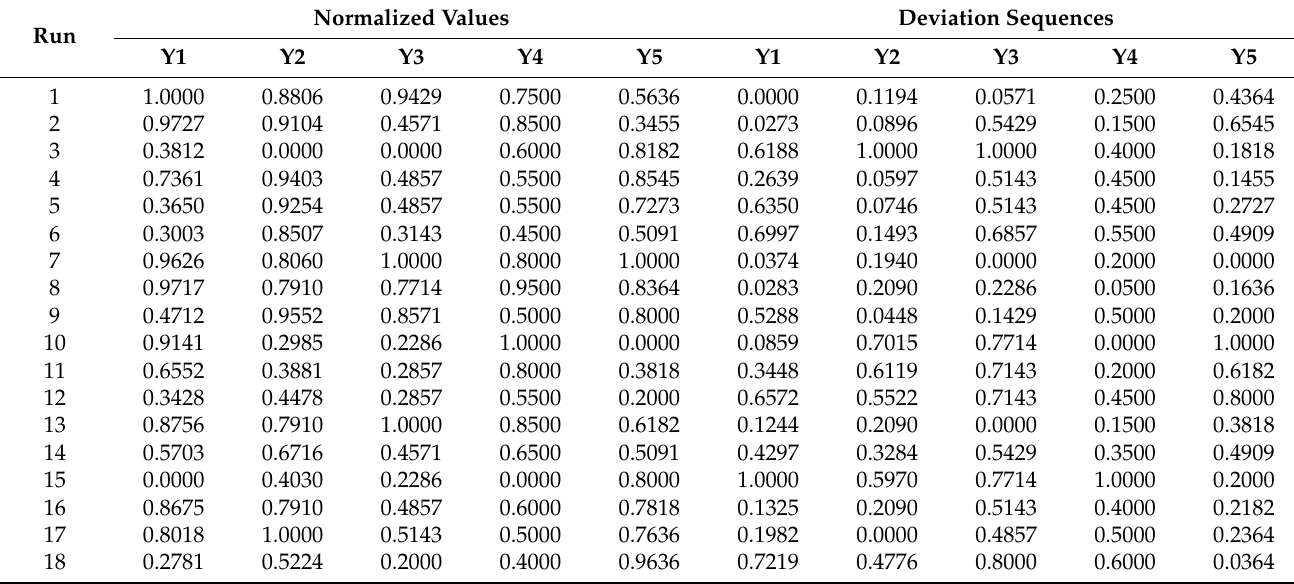
Table 7. Original experimental data after normalization and their corresponding deviations during the flocculation of the Bacillus sp. BioSol021 cultivation broth and antimicrobial activity testing against the selected